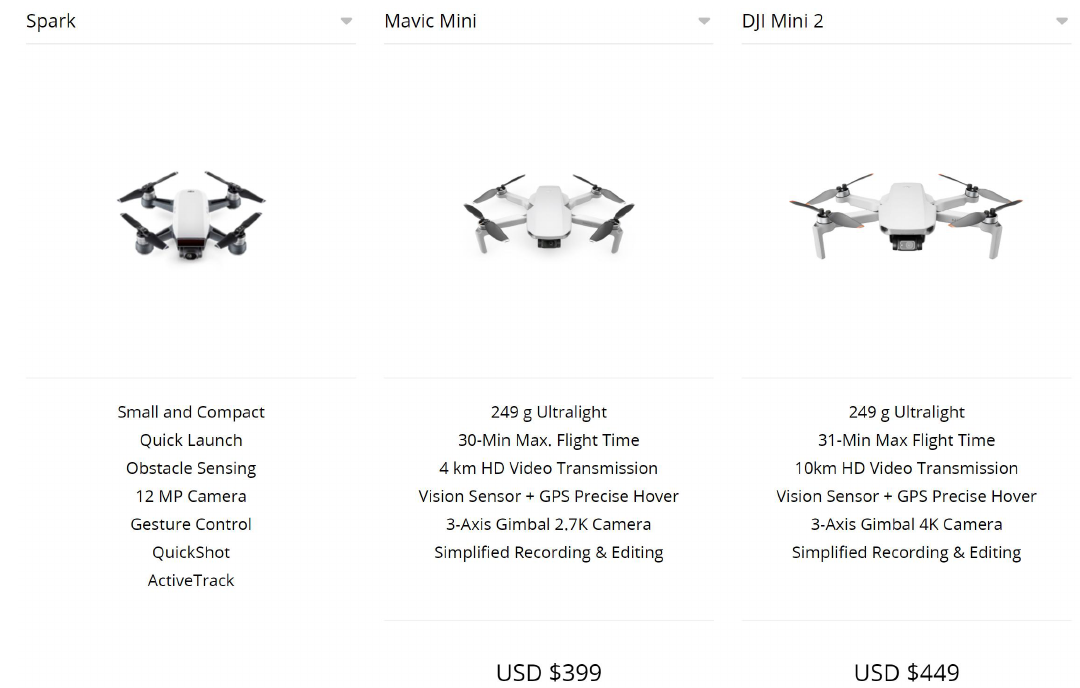
Figure 3. A comparison of the three smallest drones produced by DJI. This comparison tool is available on the DJI website [19].